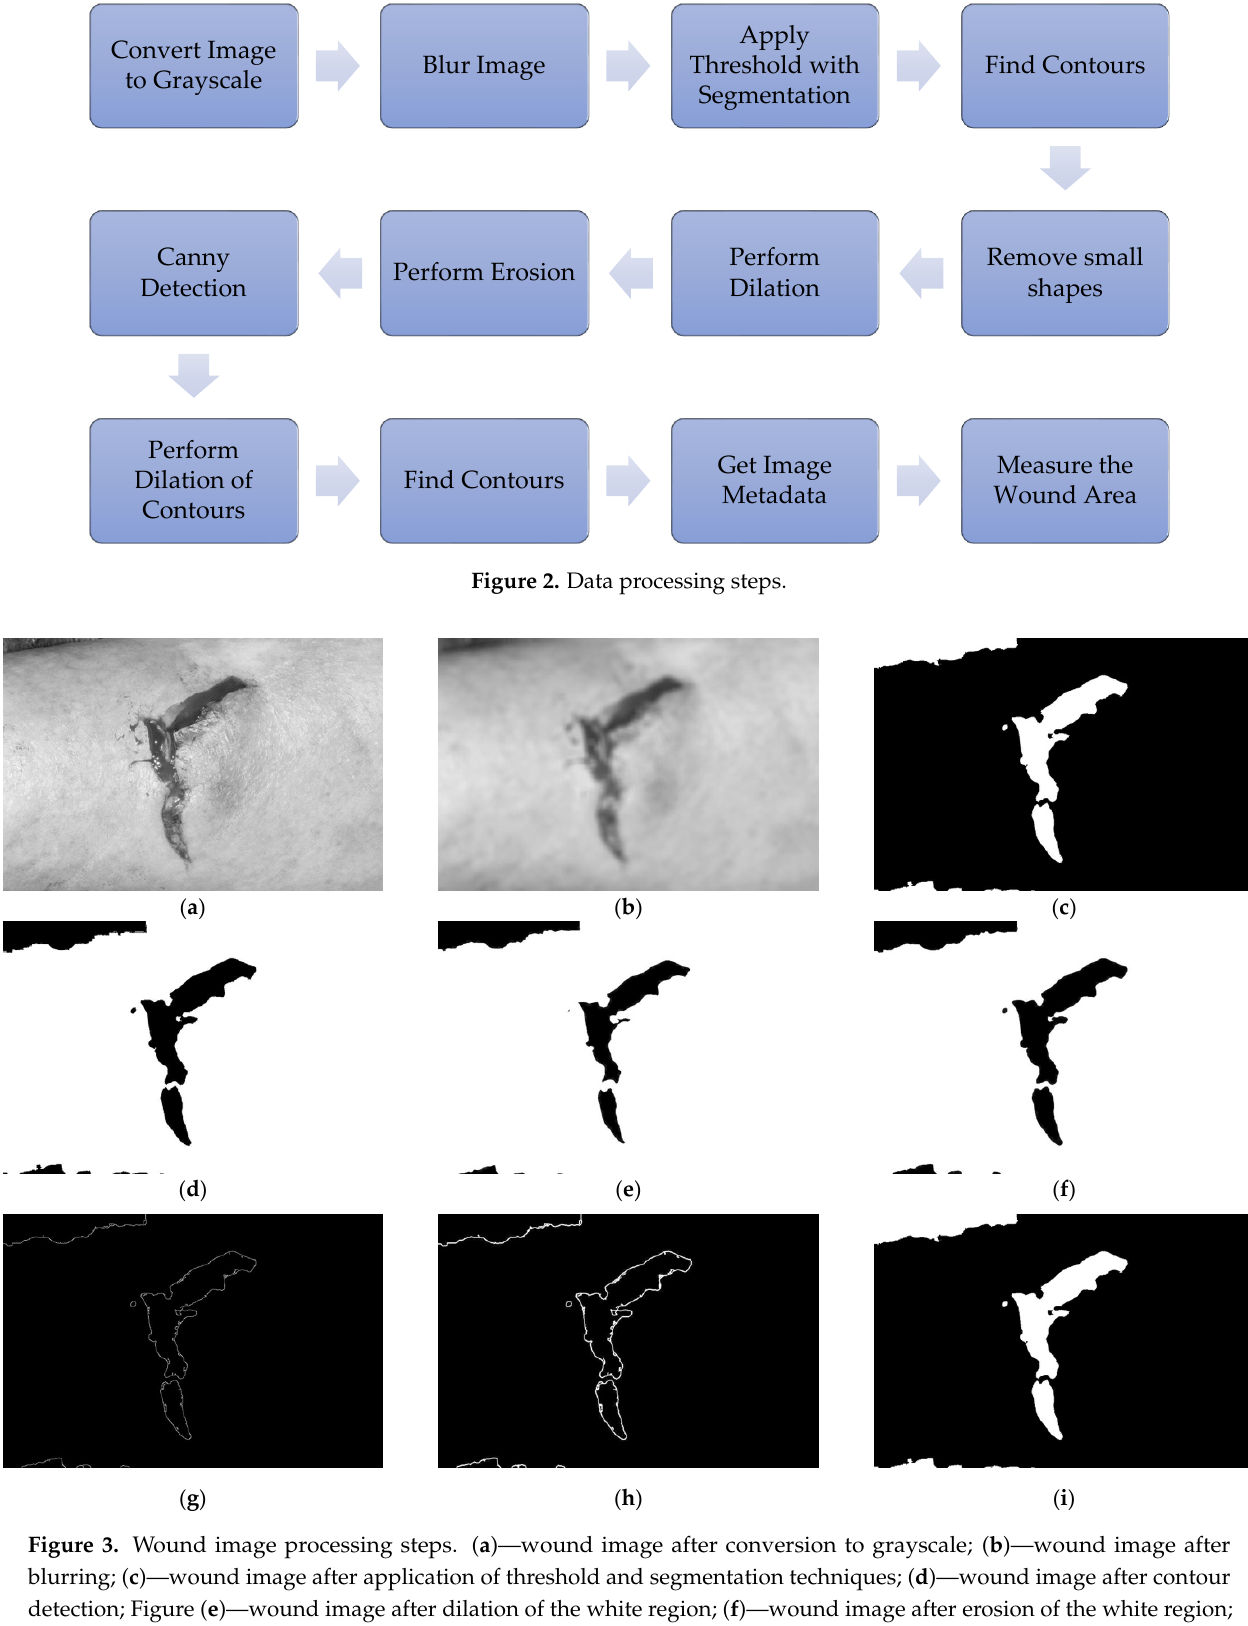
Figure 3. Wound image processing steps. Figure ( a )—wound image after conversion to grayscale; Figure ( b )—wound image after blurring; Figure ( c )—wound image after application of threshold and segmentation techniques; Figure ( d )—wound image after contour detection; Figure ( e )—wound image after dilation of the white region; Figure ( f )—wound image after erosion of the white region; Figure ( g )—wound image contours after canny detection; Figure ( h )—wound image contours after dilation; Figure ( i )—final wound image.